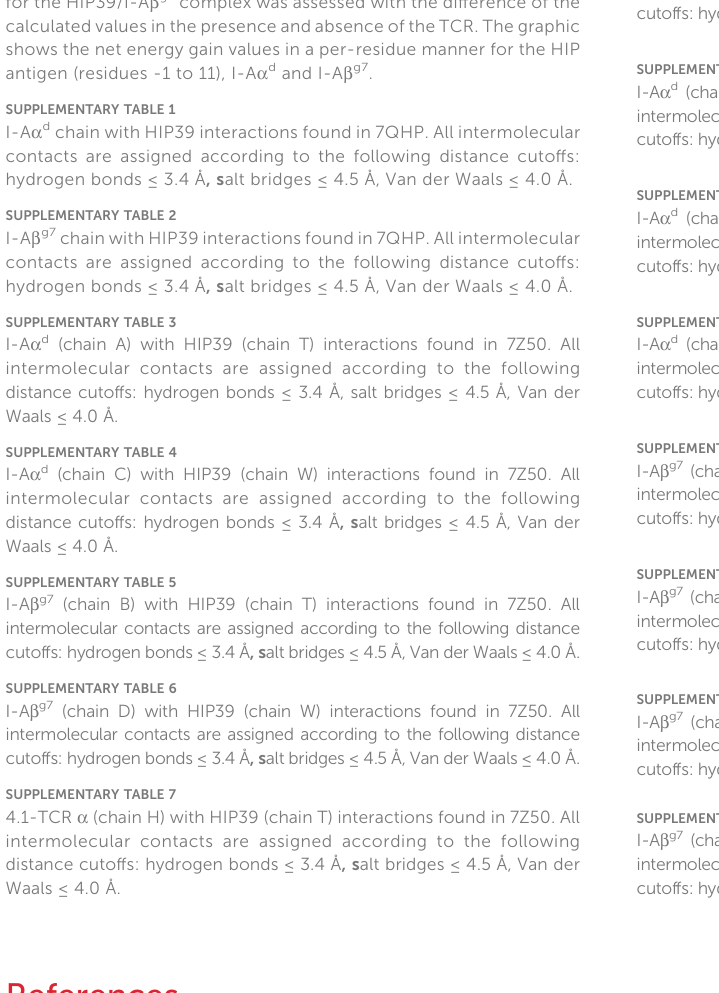
SUPPLEMENTARY TABLE 9 4.1-TCR b (chain E) with HIP39 (chain T) interactions found in 7Z50. All intermolecular contacts are assigned according to the following distance cutoffs: hydrogen bonds ≤ 3.4 Å , s altbridges ≤ 4.5Å, Van der Waals ≤ 4.0